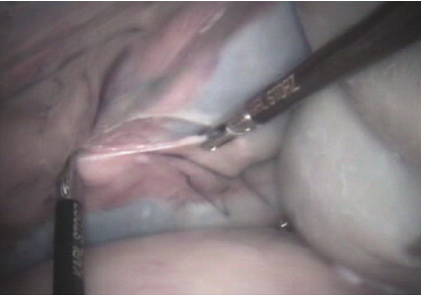
Figure 3: Dissection of the peritoneum to access the left kidney using 43cm length 5mm diameter bariatric instruments.